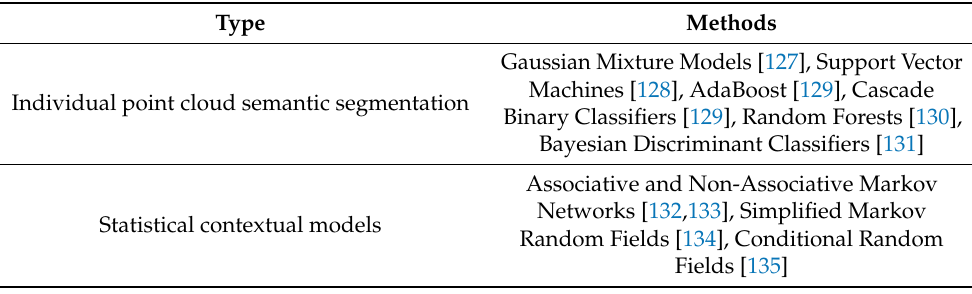
Table 7. 3D point-cloud semantic segmentation